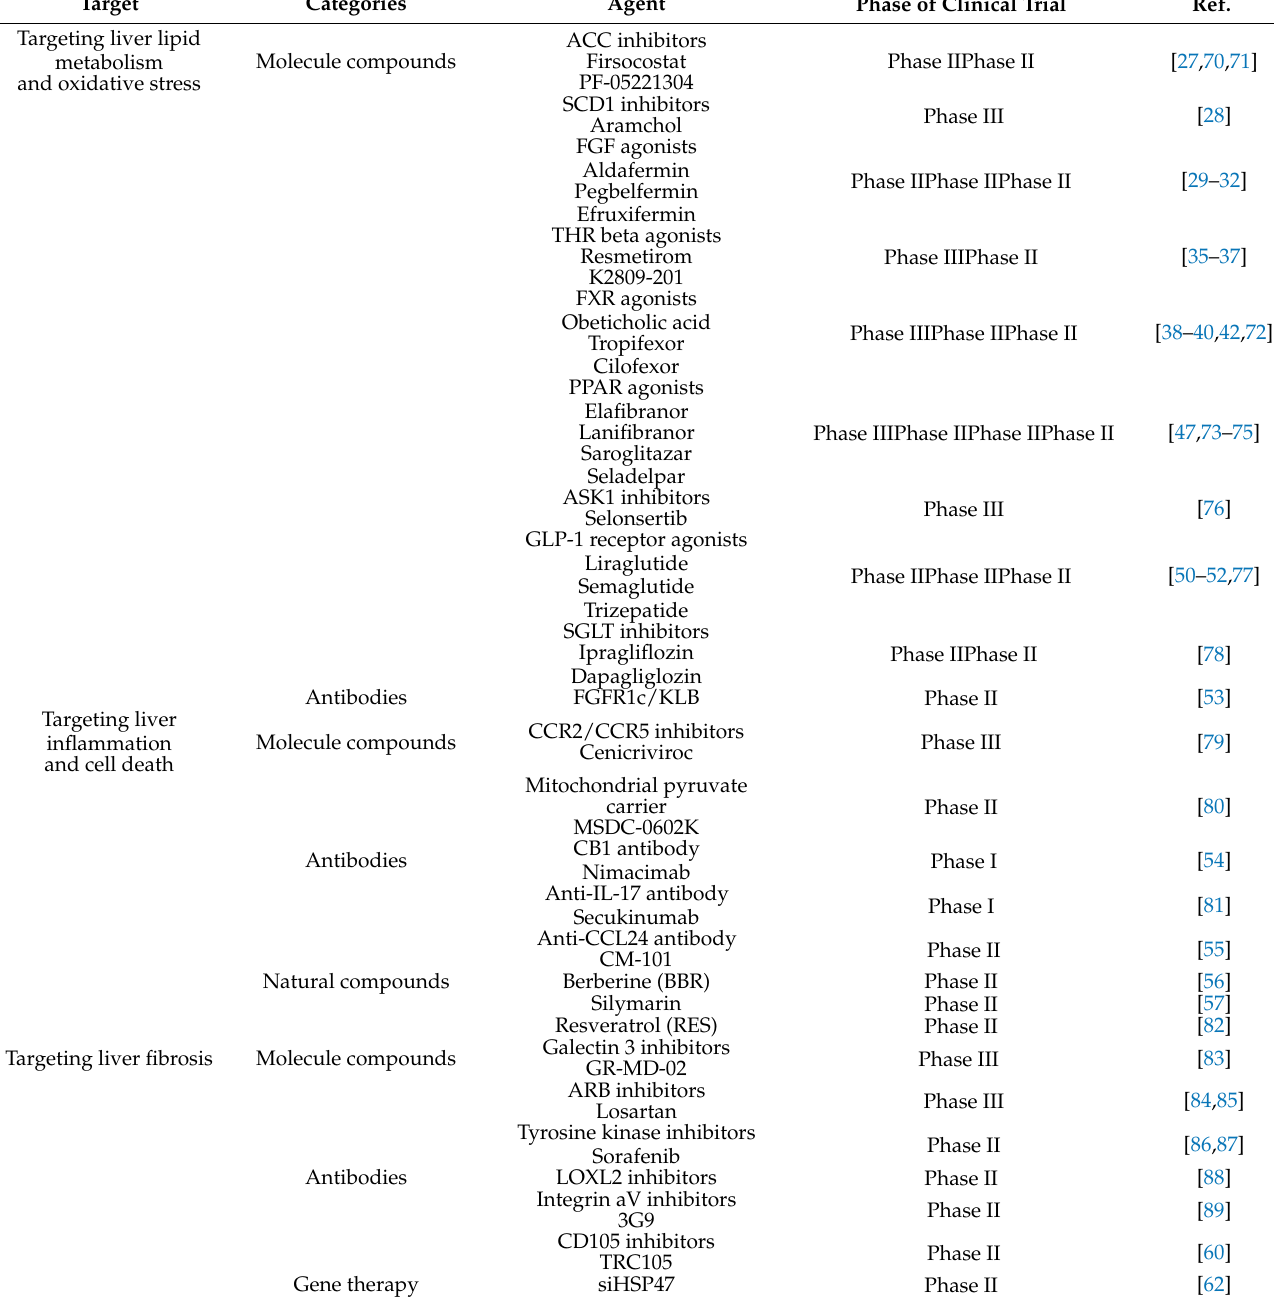
Table 1. Current clinical trials in liver